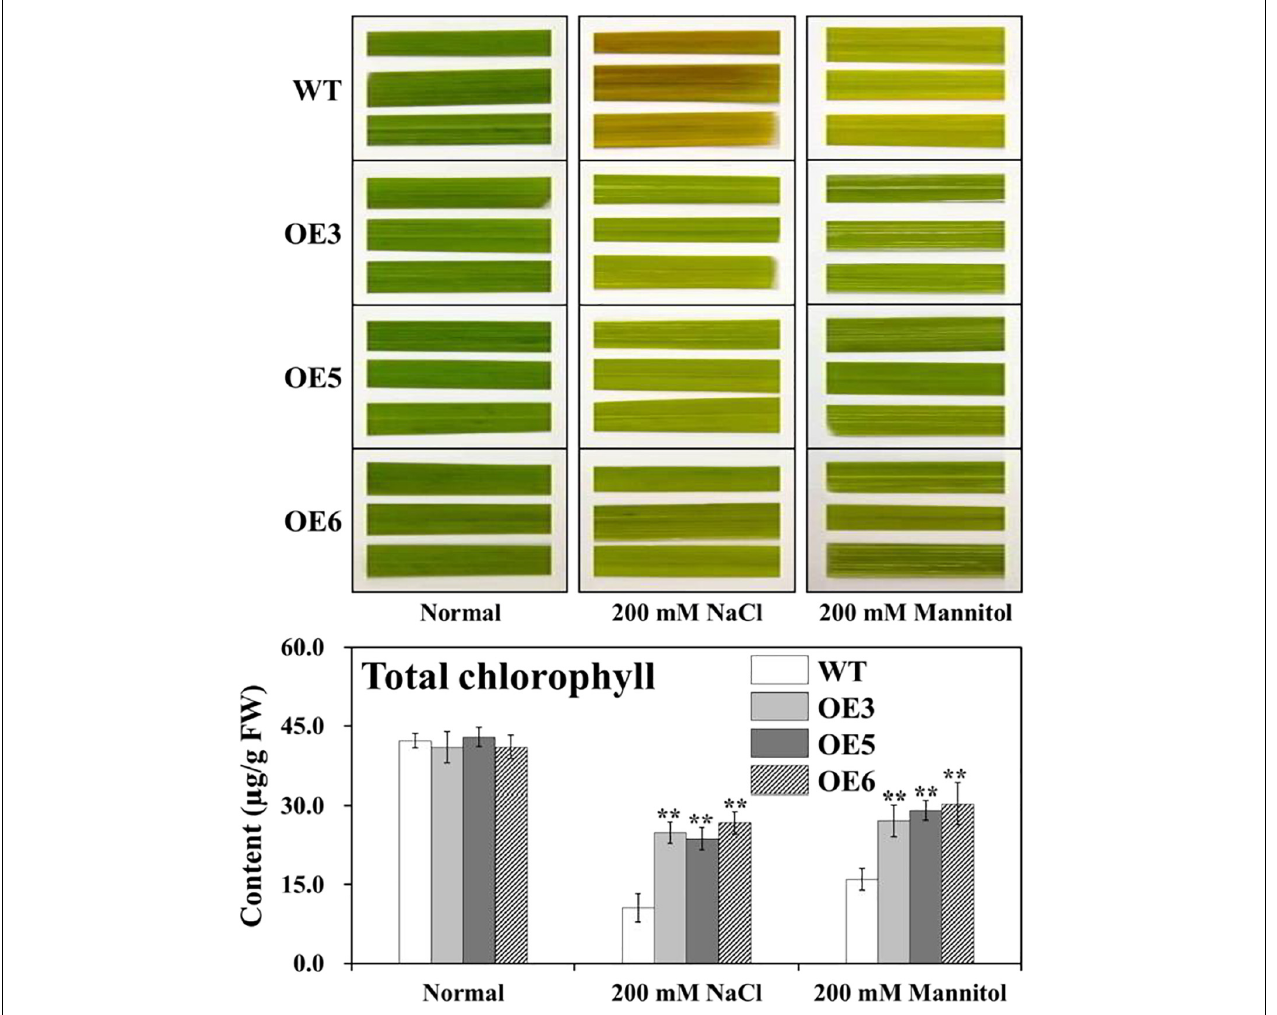
FIGURE 4 | Assessment of the NaCl- and mannitol-induced senescence in leaf disks of various transgenic plants. Leaf disks were floated on 200 mM of NaCl and 200 mM of mannitol concentrations, respectively, for 96 h at 28 ◦ C under conditions of 28 ◦ C and a 16 h light/8 h dark photoperiod cycle. Disks floated on sterile distilled water served as an experimental control. Determination of total chlorophyll content of the leaf disks after NaCl and Mannitol treatments, respectively, are presented. Data are presented as means ± SE ( n = 3). The values of * and ** indicate a significant difference from that of WT at P < 0.05 and < 0.01, respectively, by Student’s t